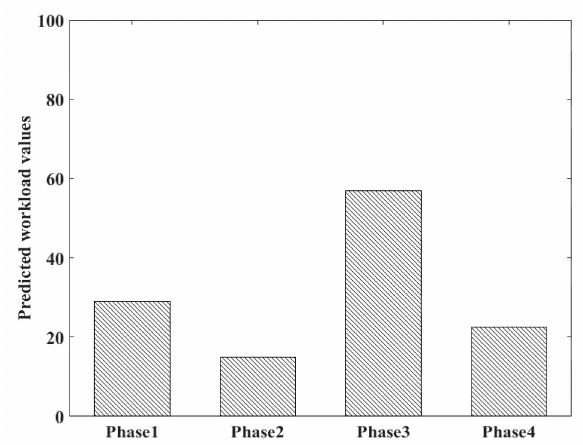
Figure 10. Mean predicted workload values during di ff erent flight phases (Phase 1: Taxiing, Phase 2: Normal Climbing, Phase 3: Maneuvering Under Fault, & Phase 4: Flaring